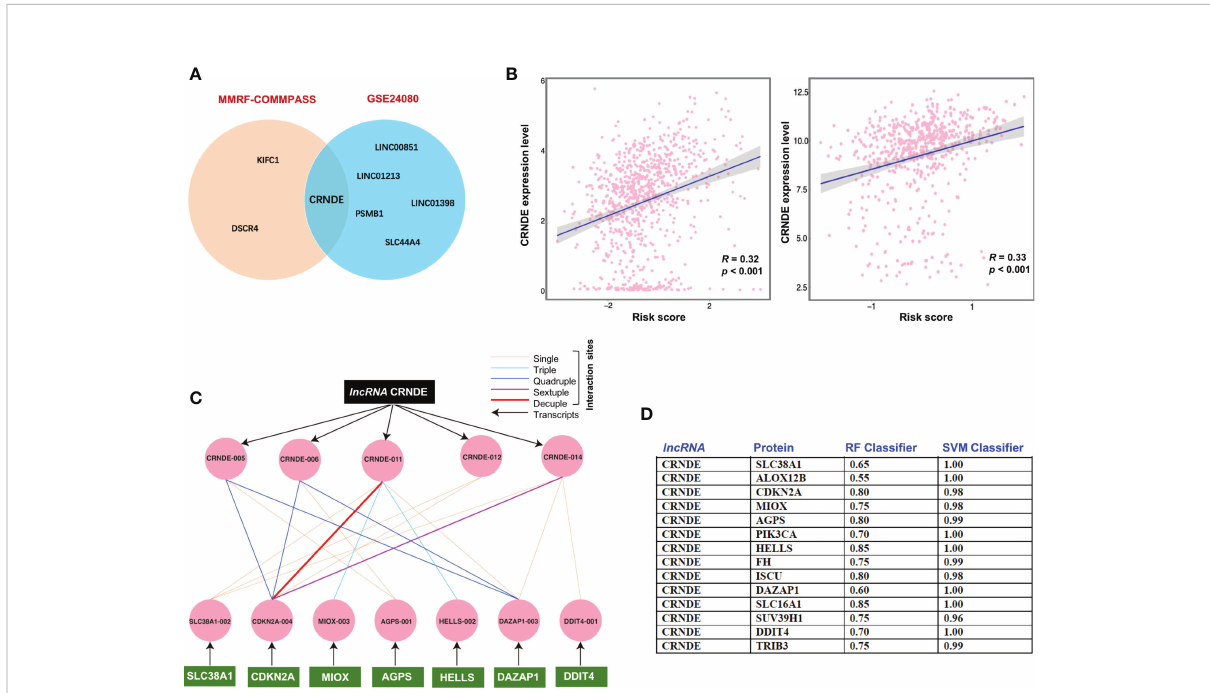
FIGURE 3 Oncogenic lncRNA CRNDE and signature genes display strong correlation. (A) The potential signi fi cant correlation of obtained ferroptosis gene signature with the lncRNAs. (B) lncRNA CRNDE was signi fi cantly correlated in both cohorts, MMRF-COMMPASS cohort (left) and GEO cohort (right). (C) The interaction between the transcript of lncRNA CRNDE and signature genes related mRNA. (D) The interaction between lncRNA CRNDE and signature genes related